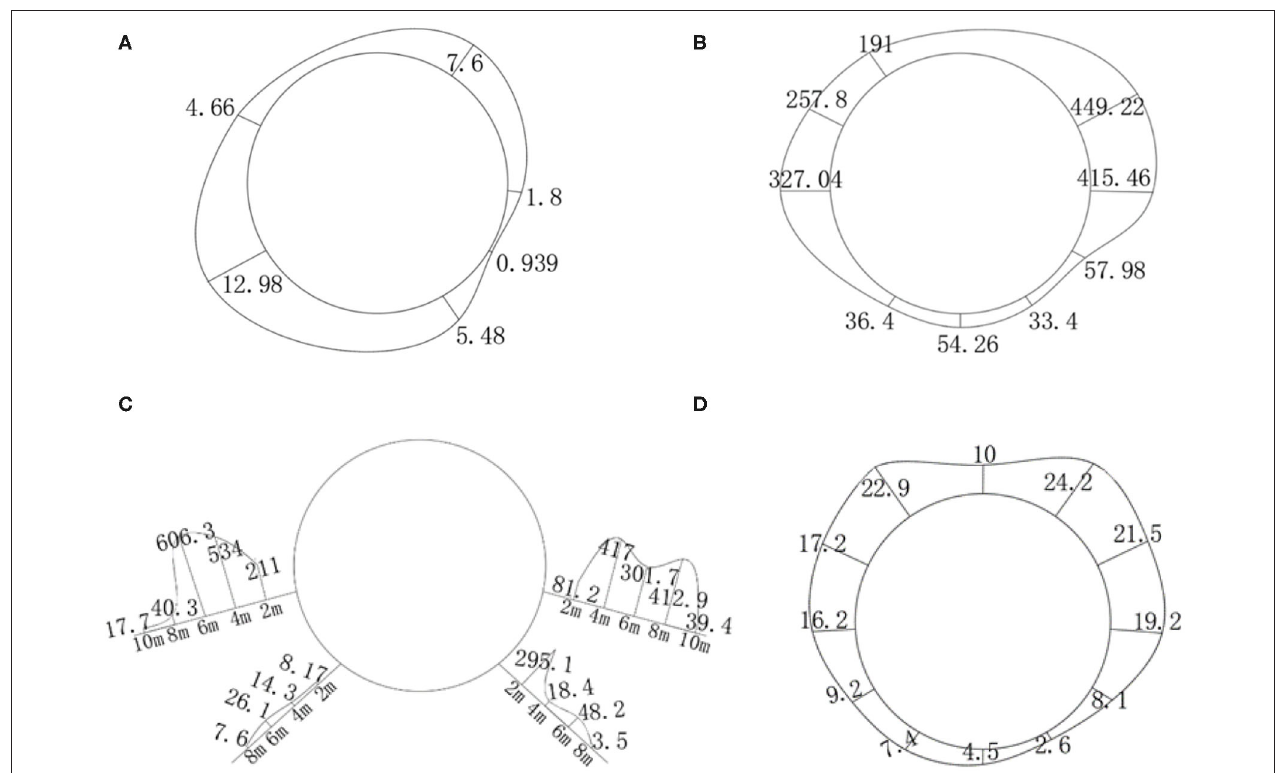
FIGURE 13 | Monitoring data diagram: (A) Initial support (B) Steel arch (C) Anchor rod (D) Secondary lining (Unit: